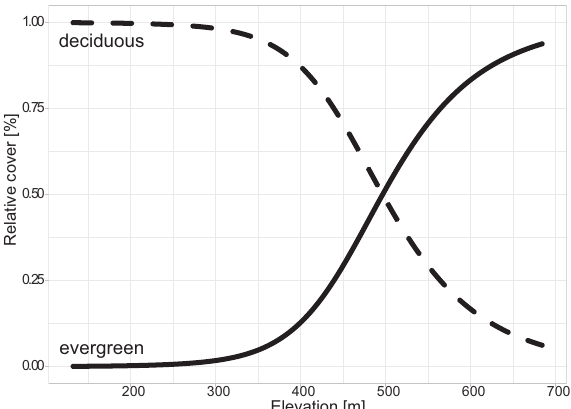
Figure 3. The relative proportions of deciduous and ever- green trees per vegetation relevé along the elevational gradient at the northern slopes of Gebel Elba. The pat- tern for deciduous tree species is shown as a dashed line while the evergreen tree species are represented by a solid line. The lines are the resulting smoothers of a cu- bic-regression